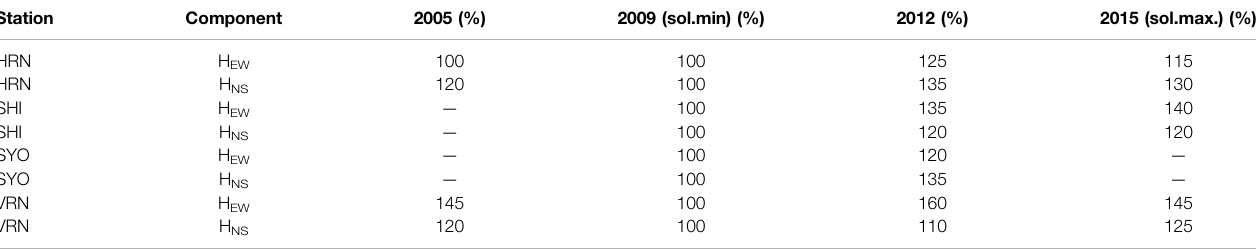
TABLE 1 | Normalized yearly averages of the fi rst SR mode ’ s intensity for the years 2005, 2009, 2012 and 2015. Station